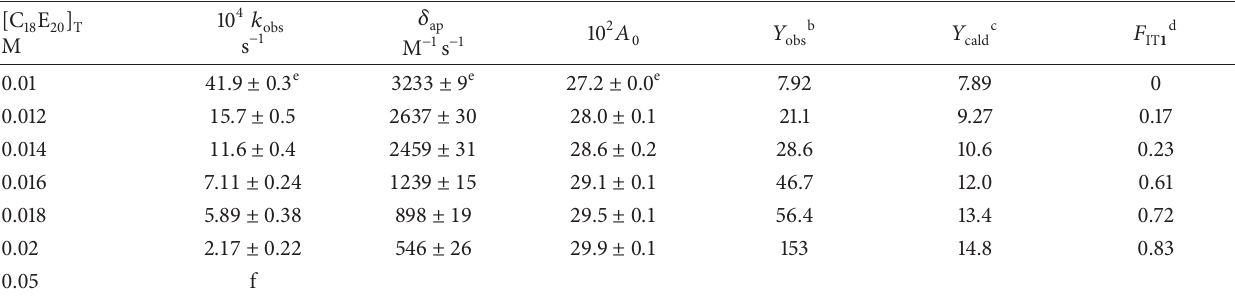
, 𝛿 , and 𝐴 0 for alkaline hydrolysis of 1 in the presence of C 18 E 20 a . obs ap